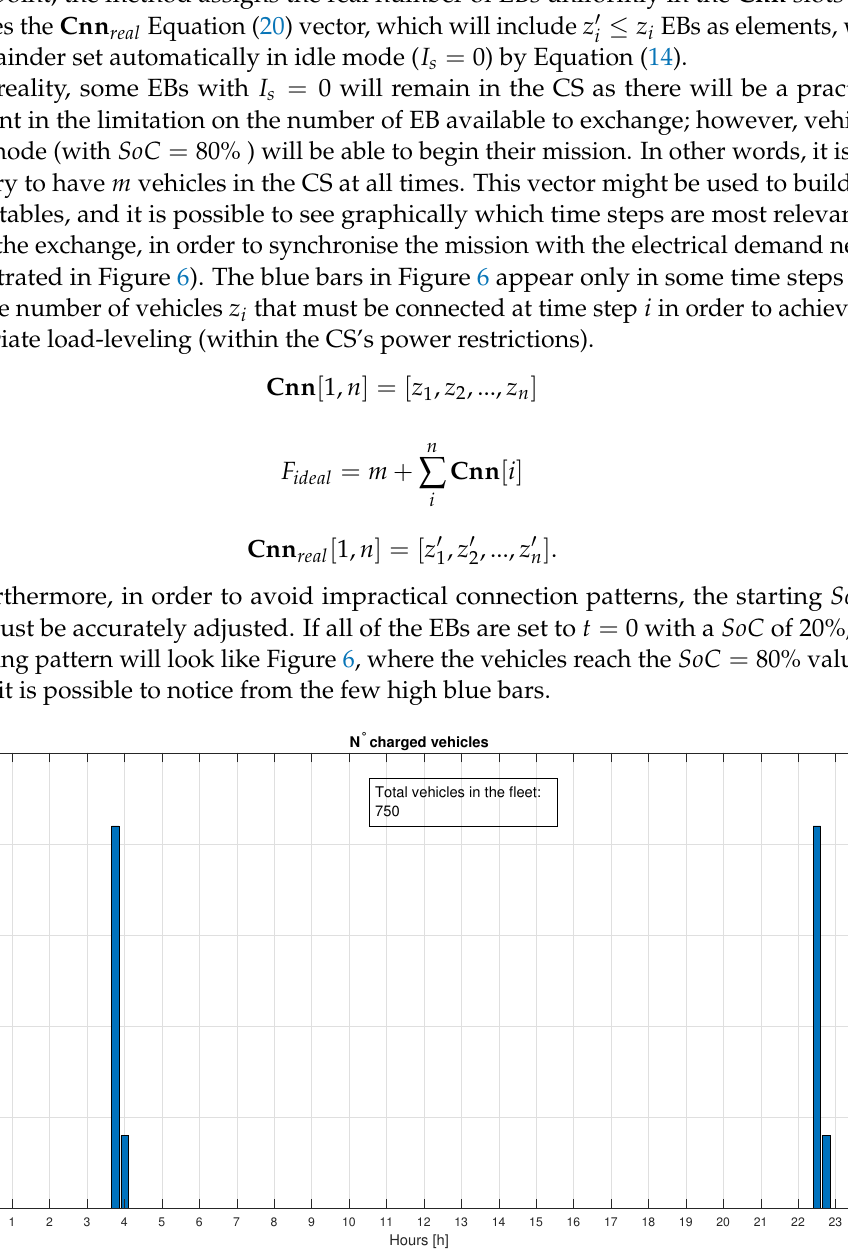
Figure 6. Connection with initial SoC = 20% for all